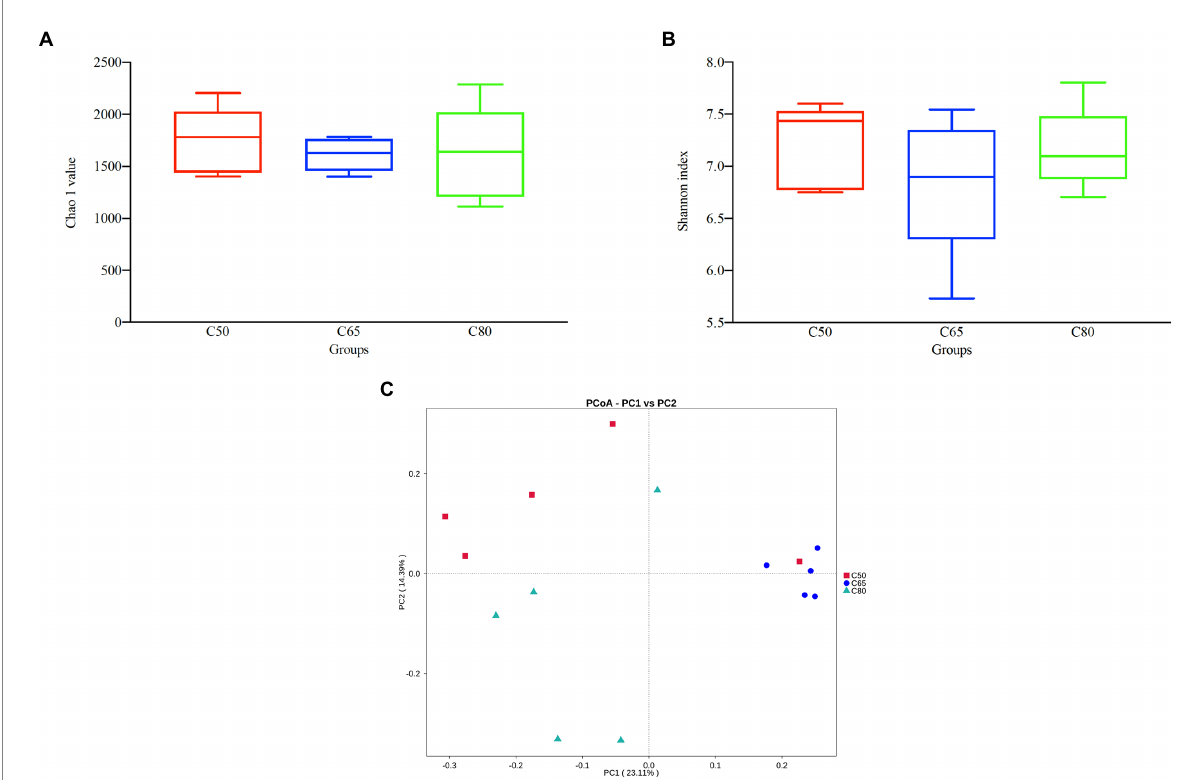
FIGURE 1 Bacterial diversity analysis of yak rumen samples for different dietary concentrate ratios. Alpha diversity between different groups’ (A) Chao 1 value and (B) Shannon index; (C) beta diversity principal coordinate analysis (PCoA). Differences based on concentrate to forage ratio of different diets were